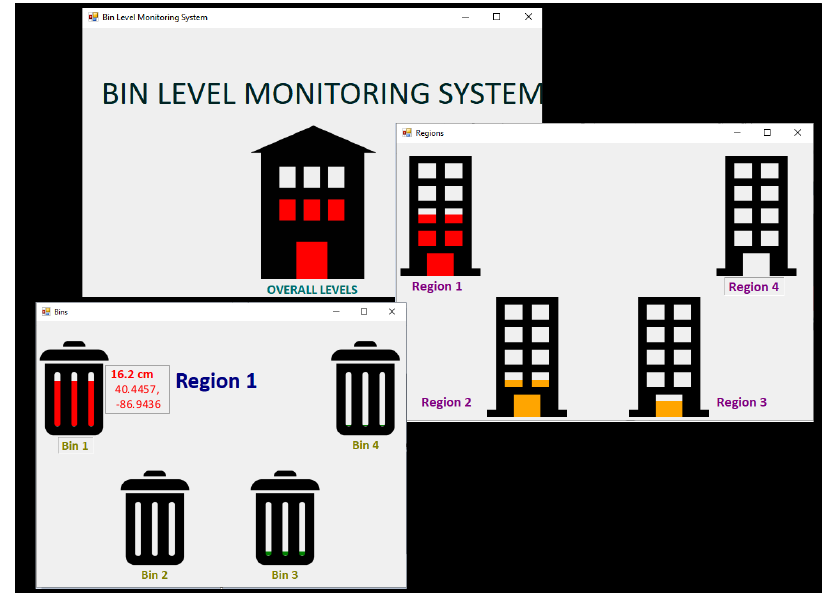
Figure 6. Screenshot of the Intelligent